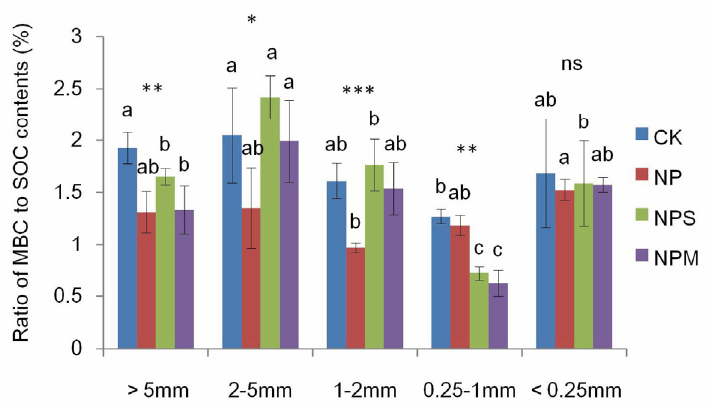
Figure 2. The ratio of MBC to SOC in different aggregates under 4 fertilization managements (CK, NP, NPS, and NPM). Different lowercase letters mean significant differences among aggregate size fractions ( p < 0.05). The differences in the ratio of MBC to SOC among the different fertilization managements are shown at *: p < 0.05, **: p < 0.01, ***: p < 0.001, and ns: not significant.